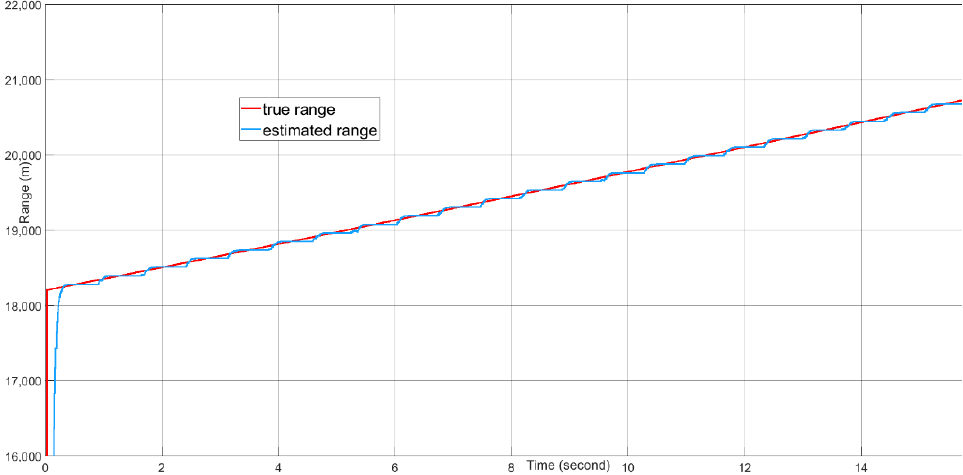
Sensors 2021 , 21 , x FOR PEER REVIEW Figure 16. The tracking performance of angle numbers 𝑎(0) and 𝑎(1) over time. Figure 16. The tracking performance of angle numbers a ( 0 ) and a ( 1 ) over time.